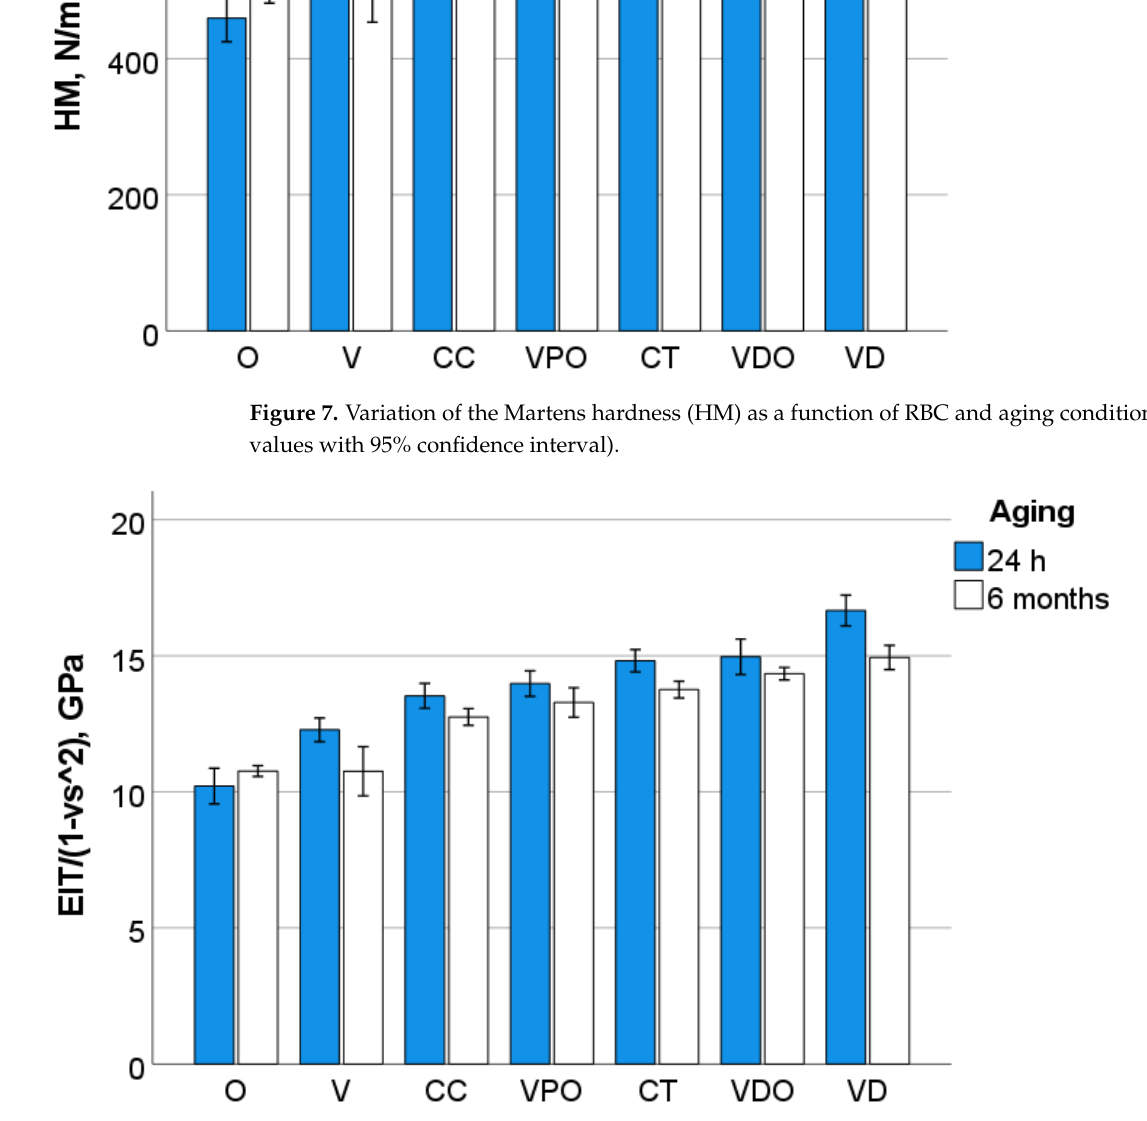
Figure 8. Variation of the indentation modulus as a function of RBC and aging conditions (mean values with 95% confidence interval).